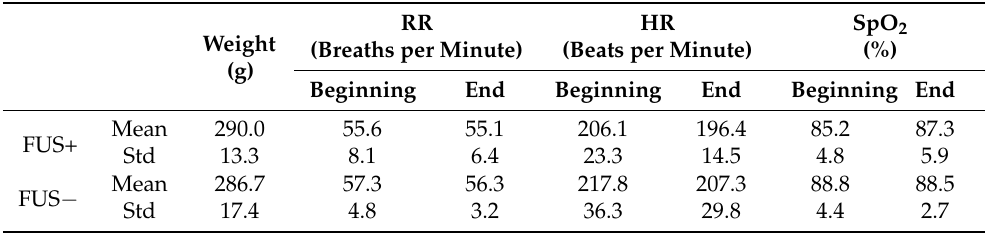
Table 1. Weight and vital signs from the animals. Respiratory/heart rates (RR and HR), and SpO 2 , measured at the onset and completion of FUS. Std: standard deviation.